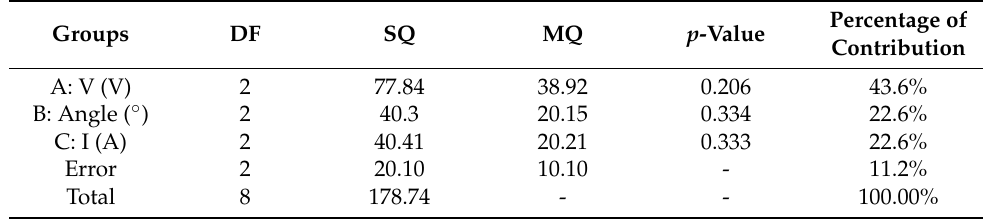
Table 9. Results obtained from ANOVA analysis for weld bead root penetration.